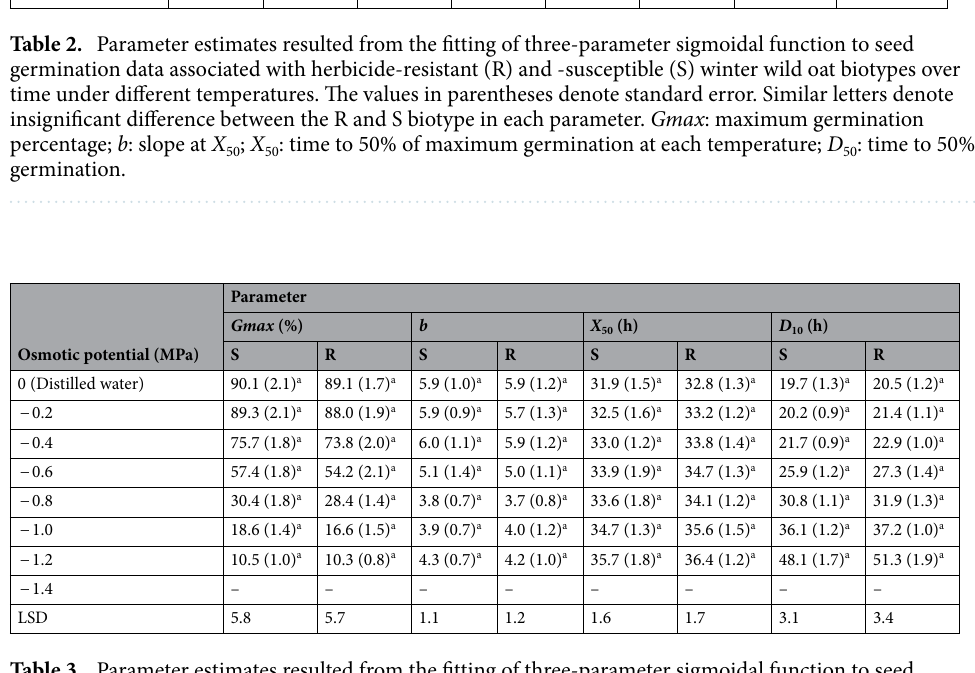
Table 3. Parameter estimates resulted from the fitting of three-parameter sigmoidal function to seed germination data associated with herbicide-resistant (R) and -susceptible (S) winter wild oat biotypes over time under different osmotic potentials. The values in parentheses denote standard error. Similar letters denote insignificant difference between the R and S biotype in each parameter. Gmax : maximum germination percentage; b : slope at X 50 ; X 50 : time to 50% of maximum germination at each temperature; D 10 : time to 10% germination.